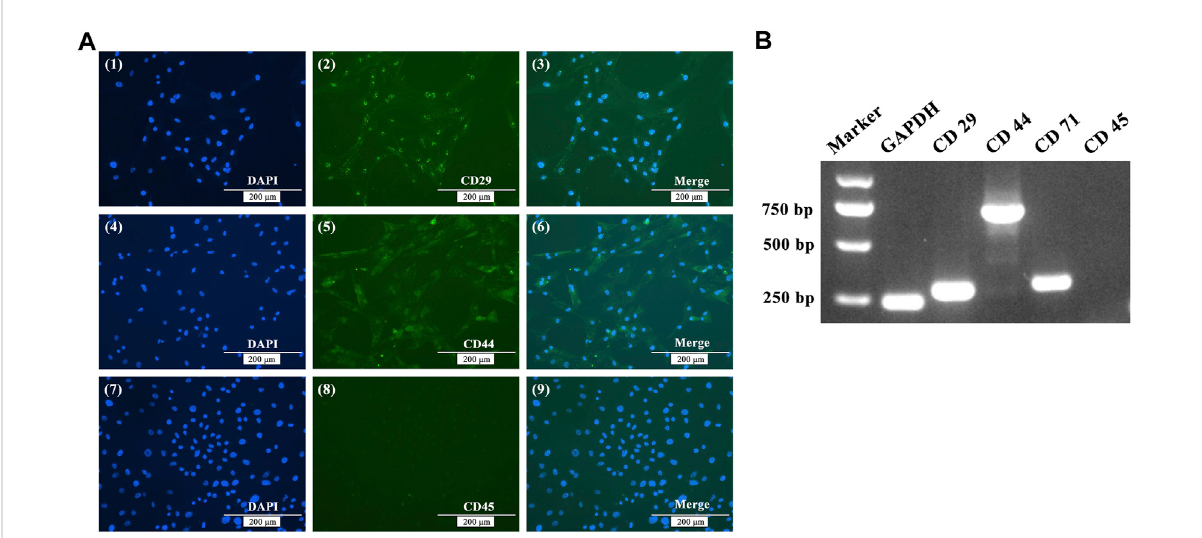
FIGURE 1 Immuno fl uorescencestaining (A) andRT-PCR (B) analysis ofBMSCcellsurfacemarkers. (A) Immuno fl uorescenceshowingpositivestainingfor CD29 and CD44, but negative for CD45. (B) RT-PCR assays showed that the expression of GADPH, CD29, CD44 and CD71 were positive, while the expression of CD45 was